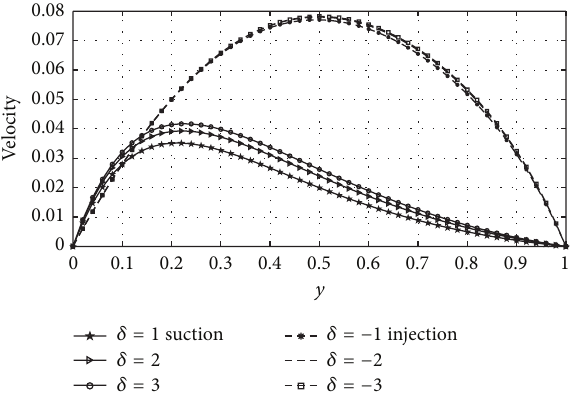
Figure 9: Effects of variable thermal conductivity ( 𝛿 ) on velocity.